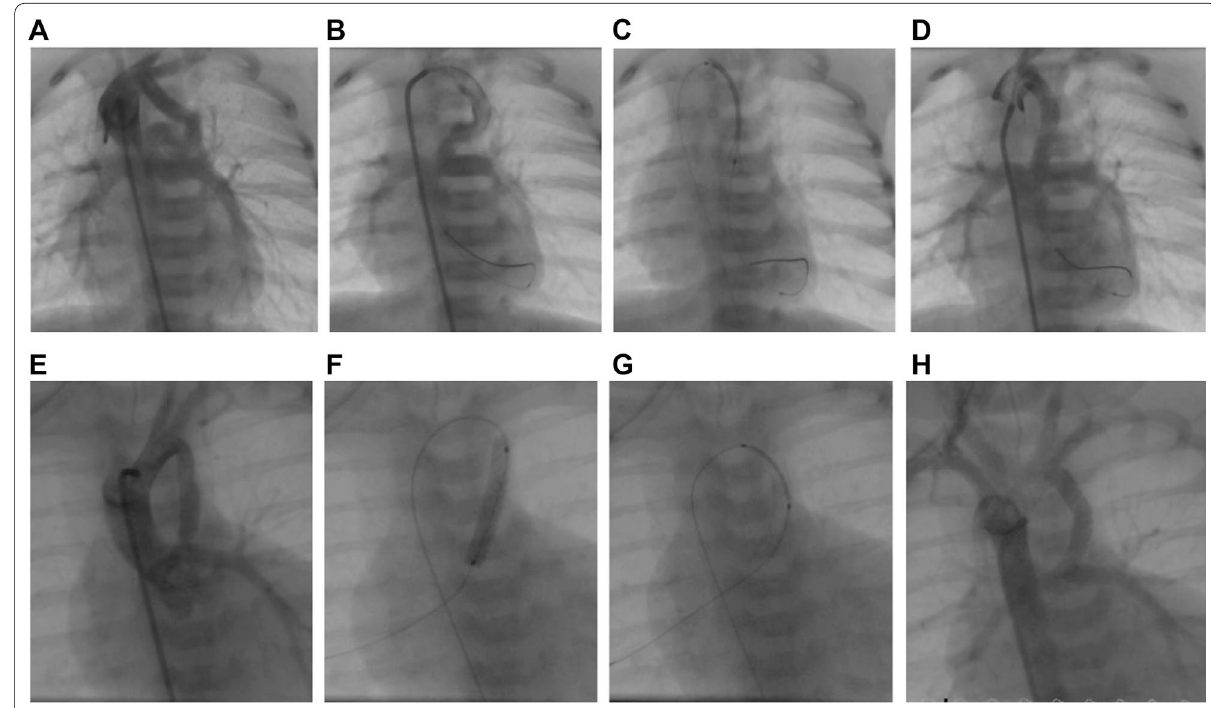
Fig. 1 Stenting a long tubular patent ductus arteriosus (PDA) from the subclavian artery. Upper panel images A – D show one stent used to cover the PDA. Lower panel images E – H show the use of 2